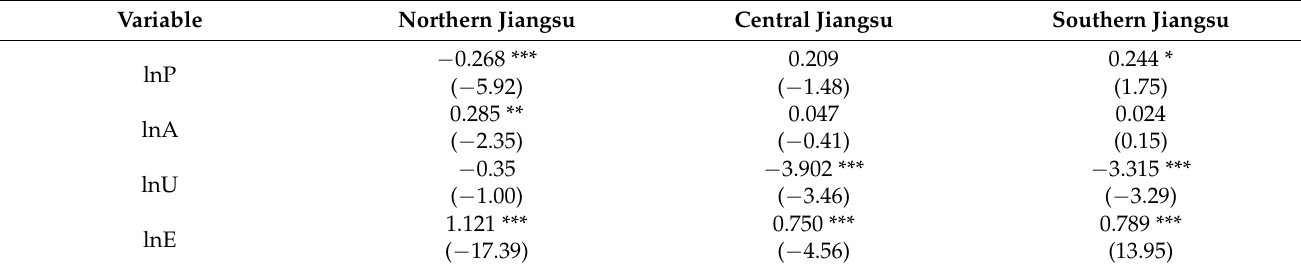
Table 8. Regression results of the threshold